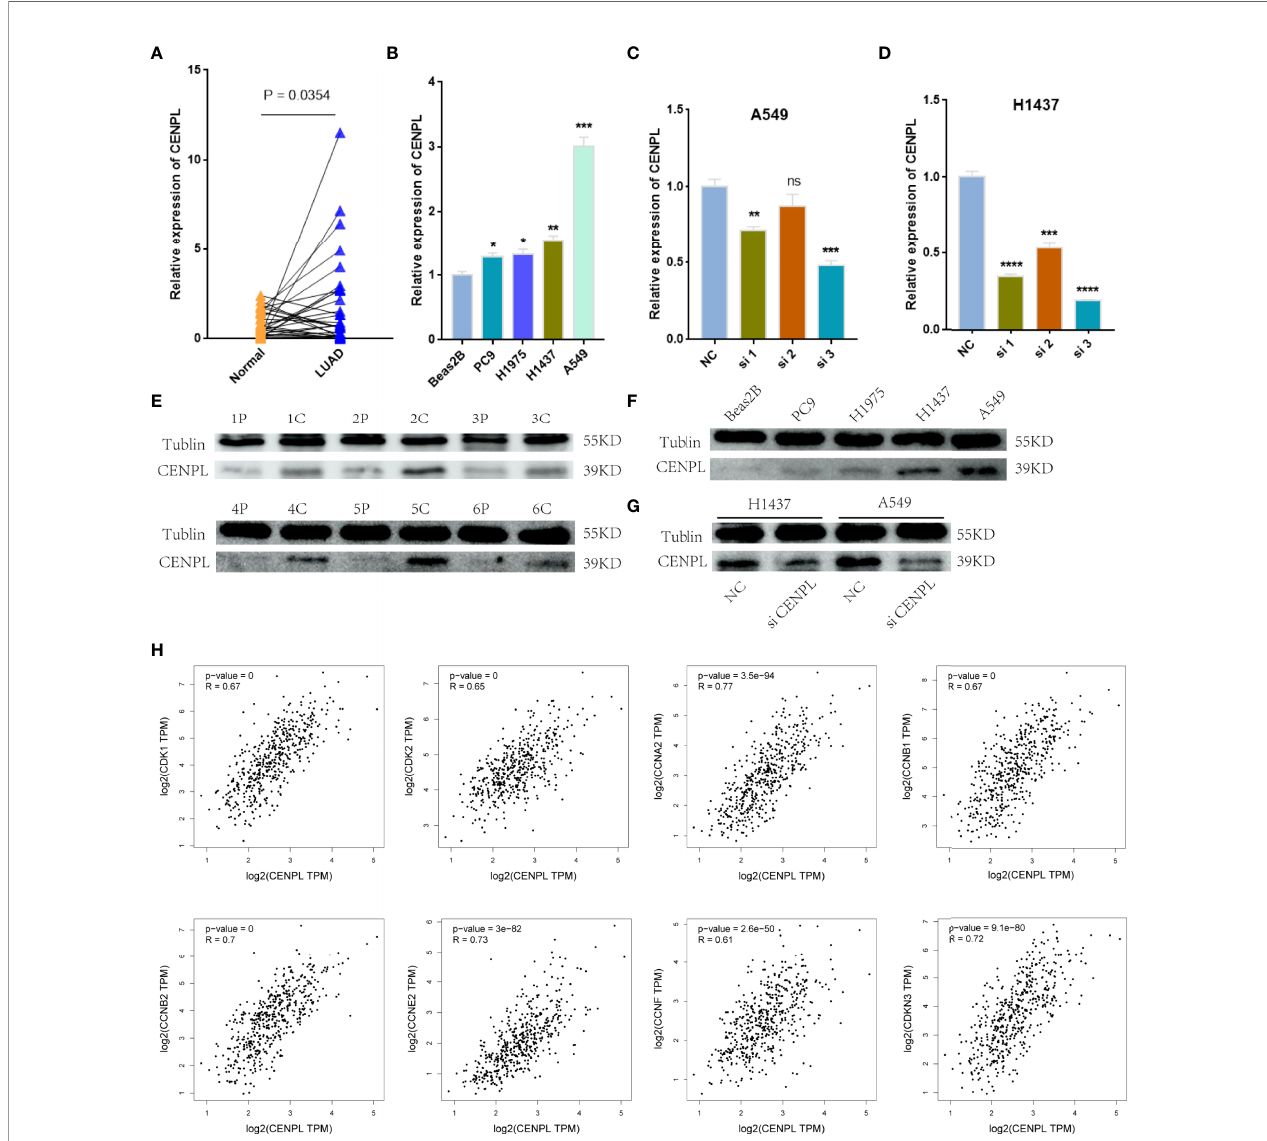
FIGURE 9 | Validation of CENPL expression. (A, B) CENPL mRNA expression in LUAD tissues and cell lines. (C, D) The knockdown ef fi ciency of CENPL mRNA in A549 and H1437 cells. (E, F) CENPL protein expression in LUAD tissues and cell lines. (G) The knockdown ef fi ciency of CENPL protein in A549 and H1437 cells. (H) The correlation between CENPL expression and CDK1, CDK2, CCNA2, CCNB1, CCNB2, CCNE2, CCNF, and CDKN3 in the GEPIA2.0 database (* p < 0.05, ** p < 0.01, *** p < 0.001, **** p < 0.0001, ns: no signi fi